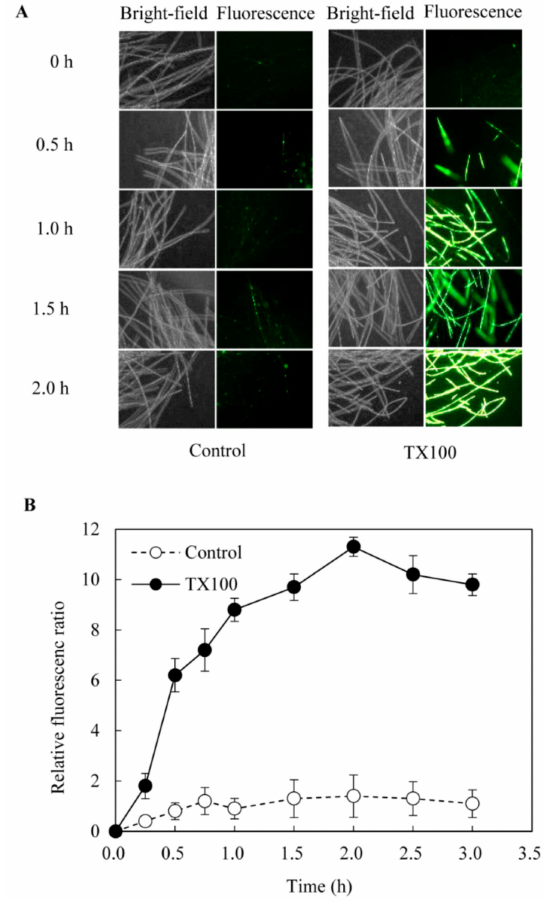
Figure 2. The membrane permeability of hyphal cells in the extractive fermentation (400 × ). ( A ) The membrane integrity of hyphal cells was detected by a nucleic acid stain fluorescent dye SYTOX Green at 0.5 µ mol / L. ( B ) The time-course of membrane permeability in the extractive fermentation. The relative fluorescence ratio is defined to the ratio of fluorescence intensity at a given time to that at 0 min. TX100 was added at 25 g / L at 36 h of the fermentation. Data shown is the mean ± SD (n =